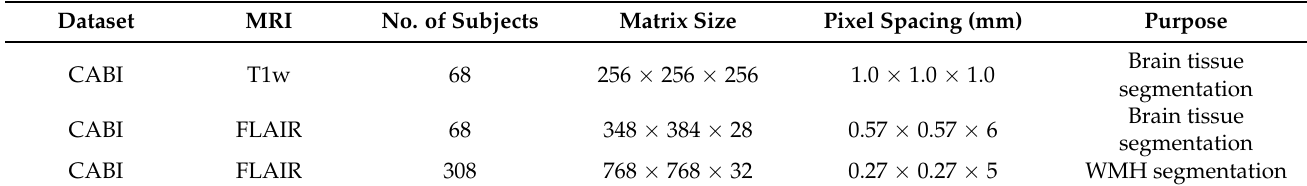
Table 1. Summary of the datasets used for training and validation.